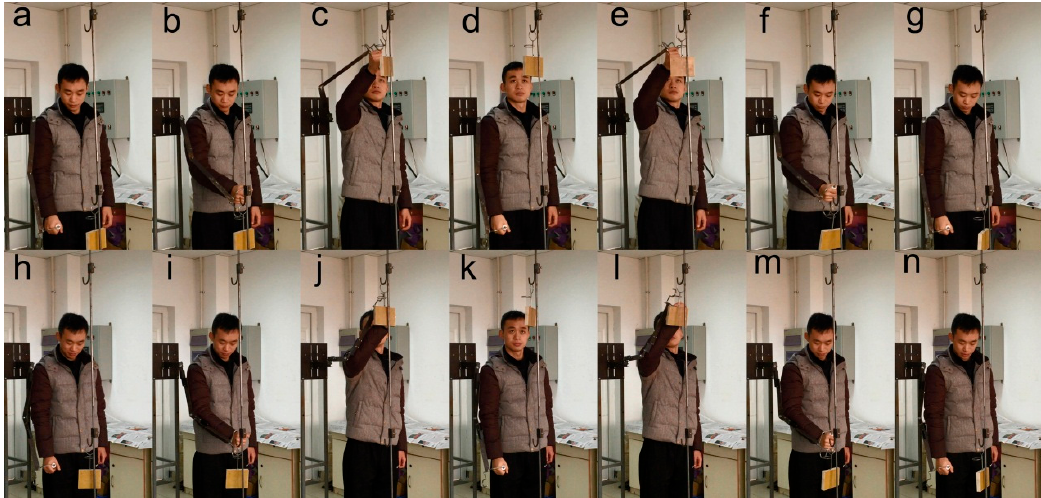
Figure 22. A complete hanging action: 3 ‐ DOF ( a – g ), 5 ‐ DOF ( h – n ).